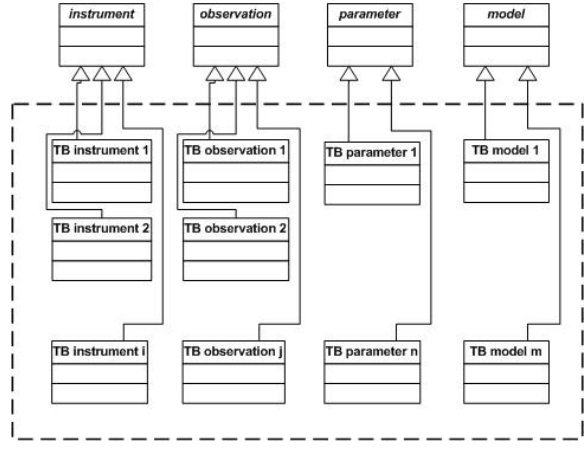
Figure 1: The GENA reference model and inheritance